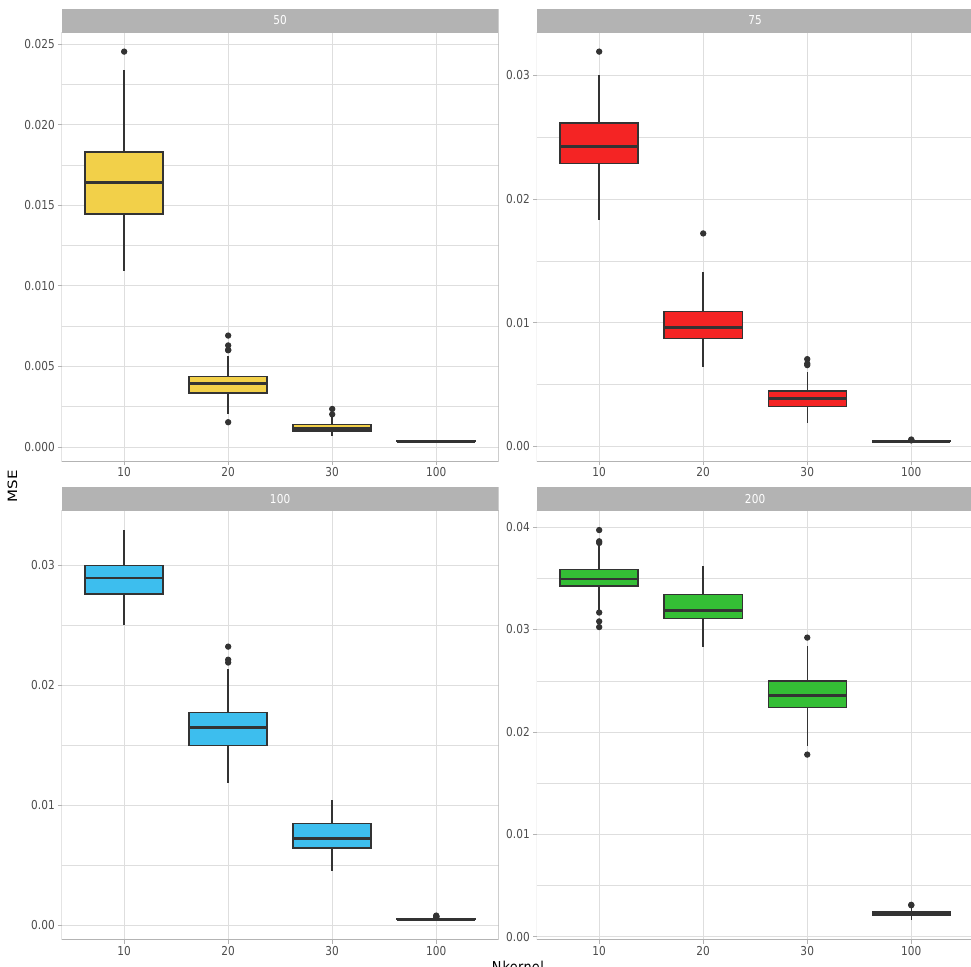
Figure 1. Illustration 1—Mean square errors (MSE) for estimating correlation parameters based on partial samples for N Total ∈ { 50,75,100,200 } (number of variables in the covariance matrix) and N kernel ∈ { 10,20, 30,100 } (number of incomplete covariance matrix samples). Each incomplete covariance matrix had a random size between 10 to 40. The MSEs are calculated over 10 replications of the